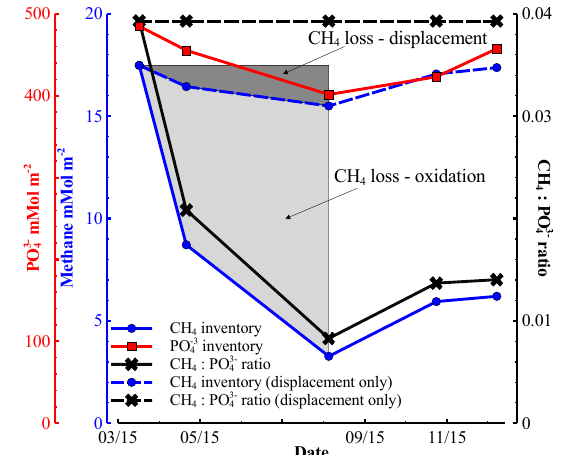
Figure 3. Evolution of the inventories of CH 4 (solid blue line with dots) and PO 3 − (solid red line with squares) below 70m at BY15, 4 and the molar inventory ratio CH 4 :PO 3 − over the year 2015 (solid 4 black line with crosses). Results from all measured depths at all sampling times were included in the integration, with the excep- tion data from June, which was omitted due to the loss of deep water CH 4 samples. Pictured also is the hypothetical evolution of the CH 4 inventory (dashed blue line with dots) if the CH 4 :PO 3 − 4 ratio (dashed black line with crosses) had remained constant during the year – i.e. the effect of water mass displacement was equal for CH 4 and PO 3 − . The lighter grey area represents the estimated loss 4 of CH 4 due to oxidation and the darker grey represents the loss due to displacement. Note the different scales of the y